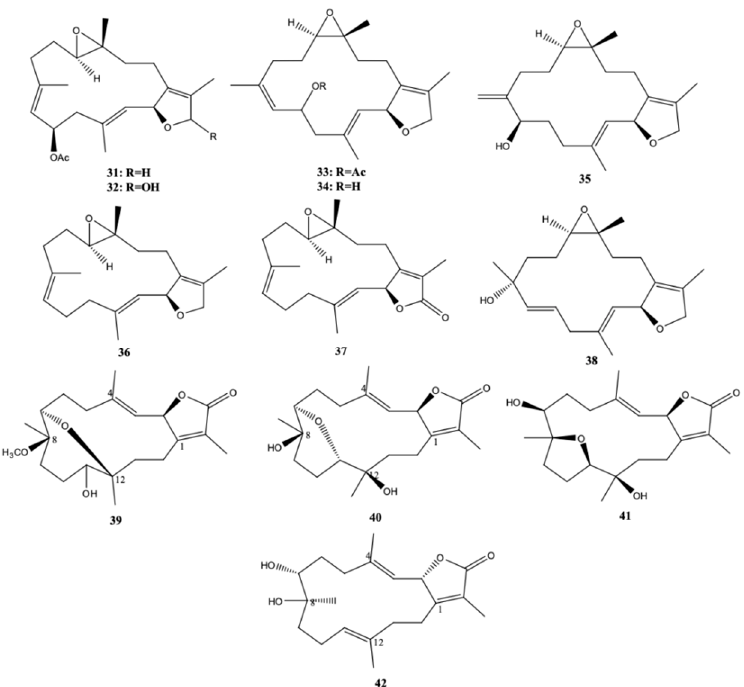
Figure 5. Cembranoid diterpenes isolated from S. ehrenbergi , from the Red Sea and South China Sea [20,27].